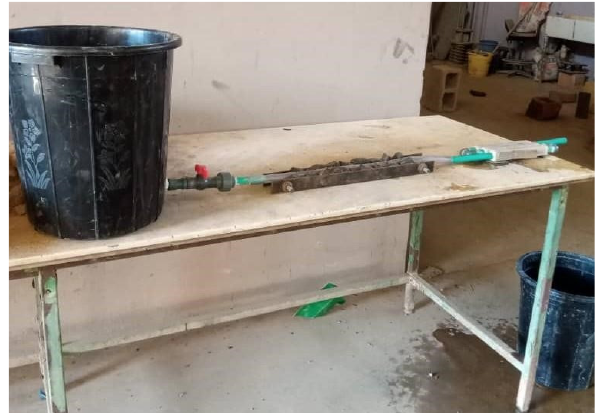
Figure 2. Magnetic treatment unit for producing the magnetized water